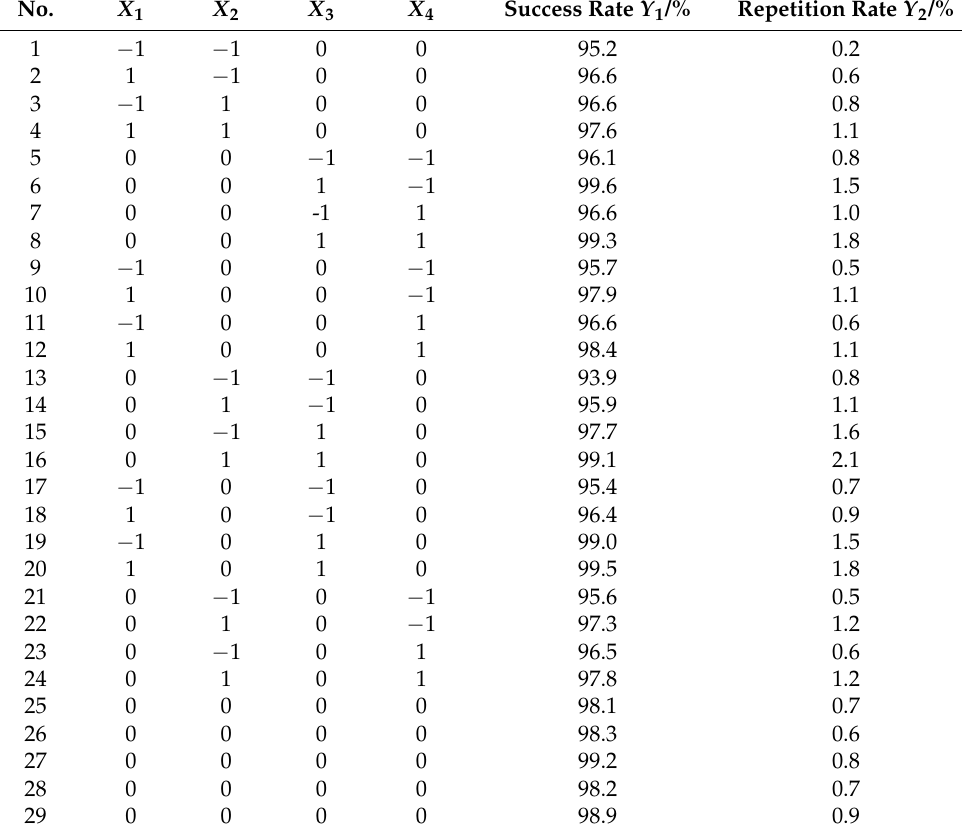
Table 1. Test scheme and response value results.